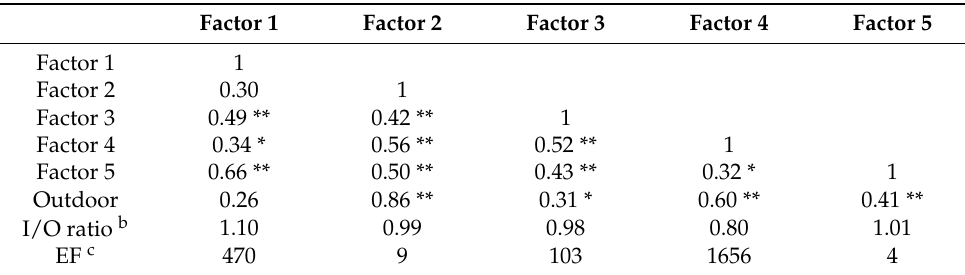
Table 3. Correlations between factors and outdoor air a , mean indoor-to-outdoor (I/O) ratios, and enrichment factors (EFs). Factor 1 Factor 2 Factor